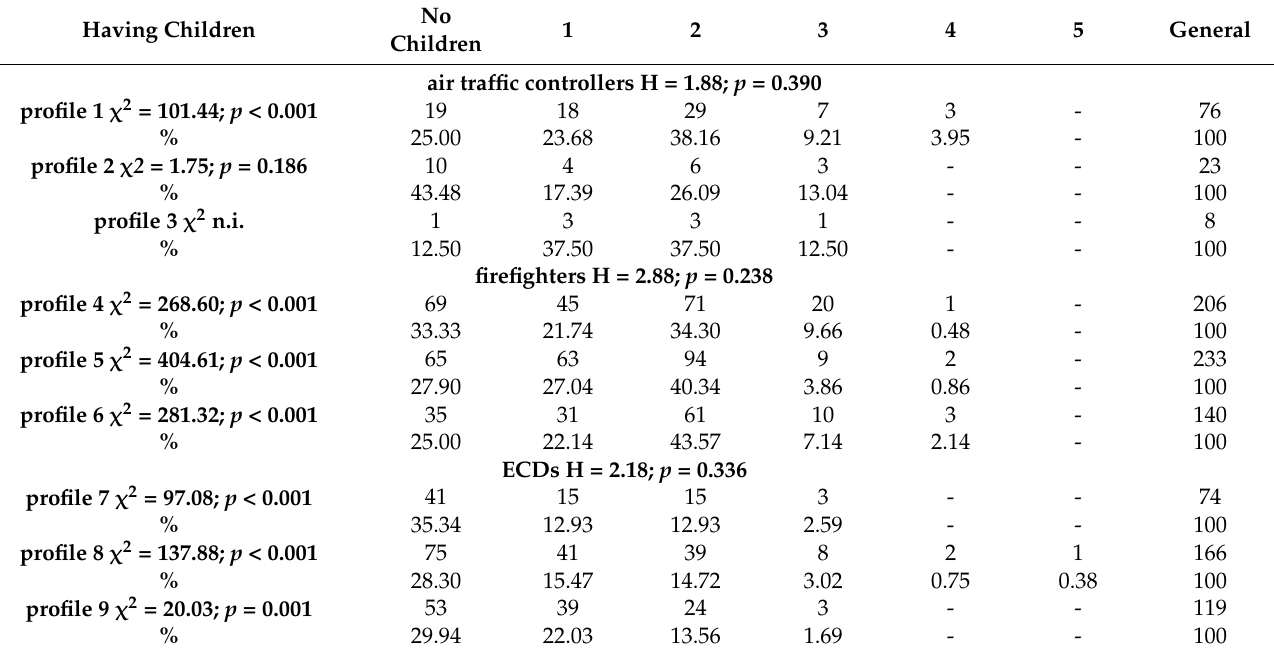
Table 5. Differences in number of children due to the profile of occupational burnout in the group of air traffic controllers, firefighters, and